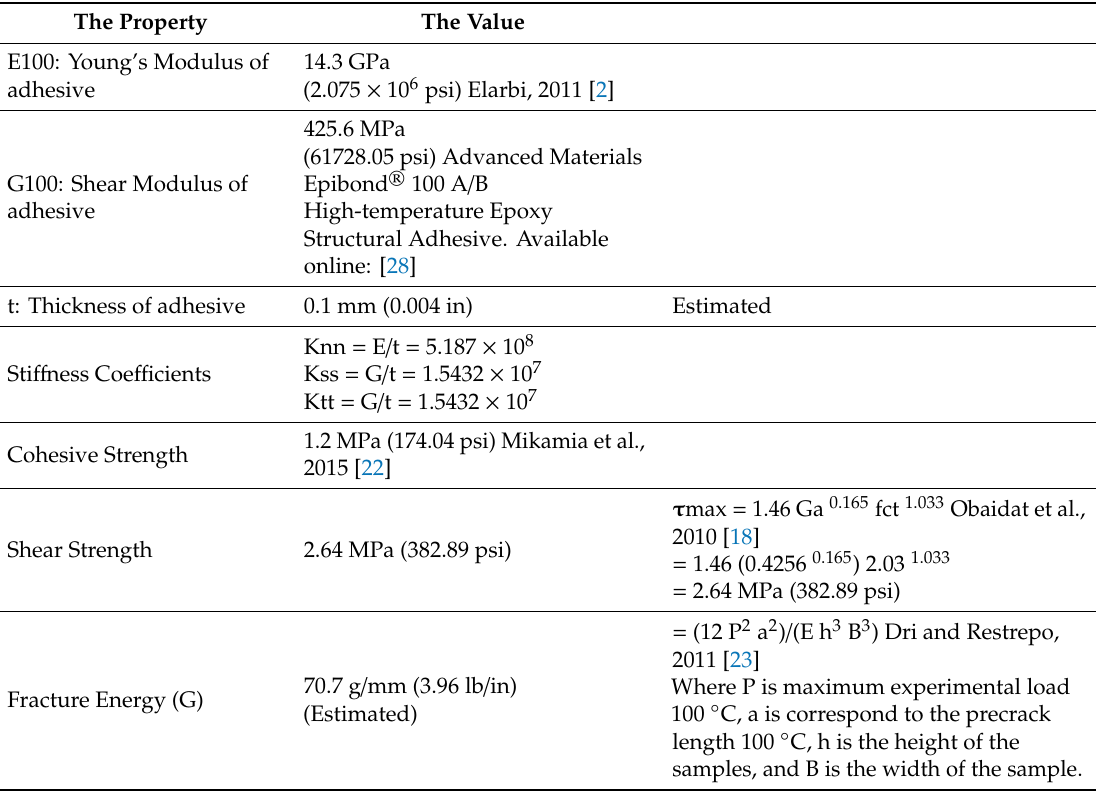
Table 6. Adhesive properties at 100 ◦